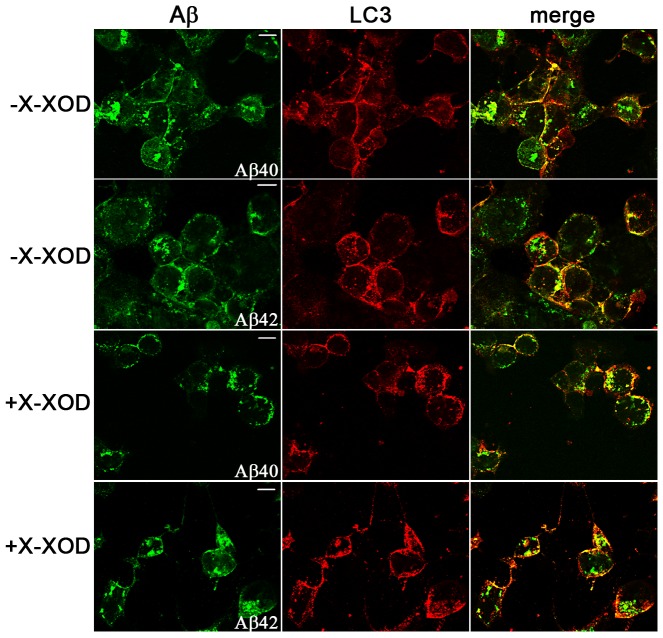
Oxidative stress does not affect the autophagosomal localization of Aβ in HSV-1-infected cells.Confocal images obtained with anti-Aβ and anti-LC3 antibodies showing endogenous LC3 and Aβ patterns in HSV-1-infected SK-APP cells at a moi of 10 for 18 h in the presence and absence of oxidative stress (X-XOD). Colocalization is shown by yellow fluorescence signals in the merged panels. Scale bar: 10 µm.